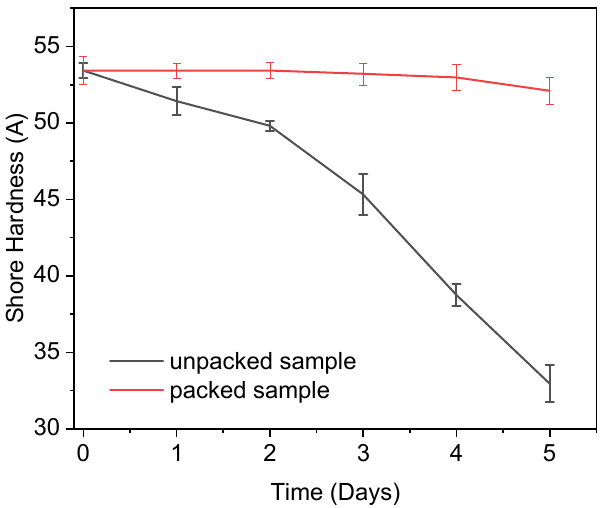
Figure 12. The graph represents the shore hardness vs. time graph in which the red line indicates the packed sample’s shore hardness A at 5 days and the black line indicates the unpacked sample’s shore hardness A after 5 days.